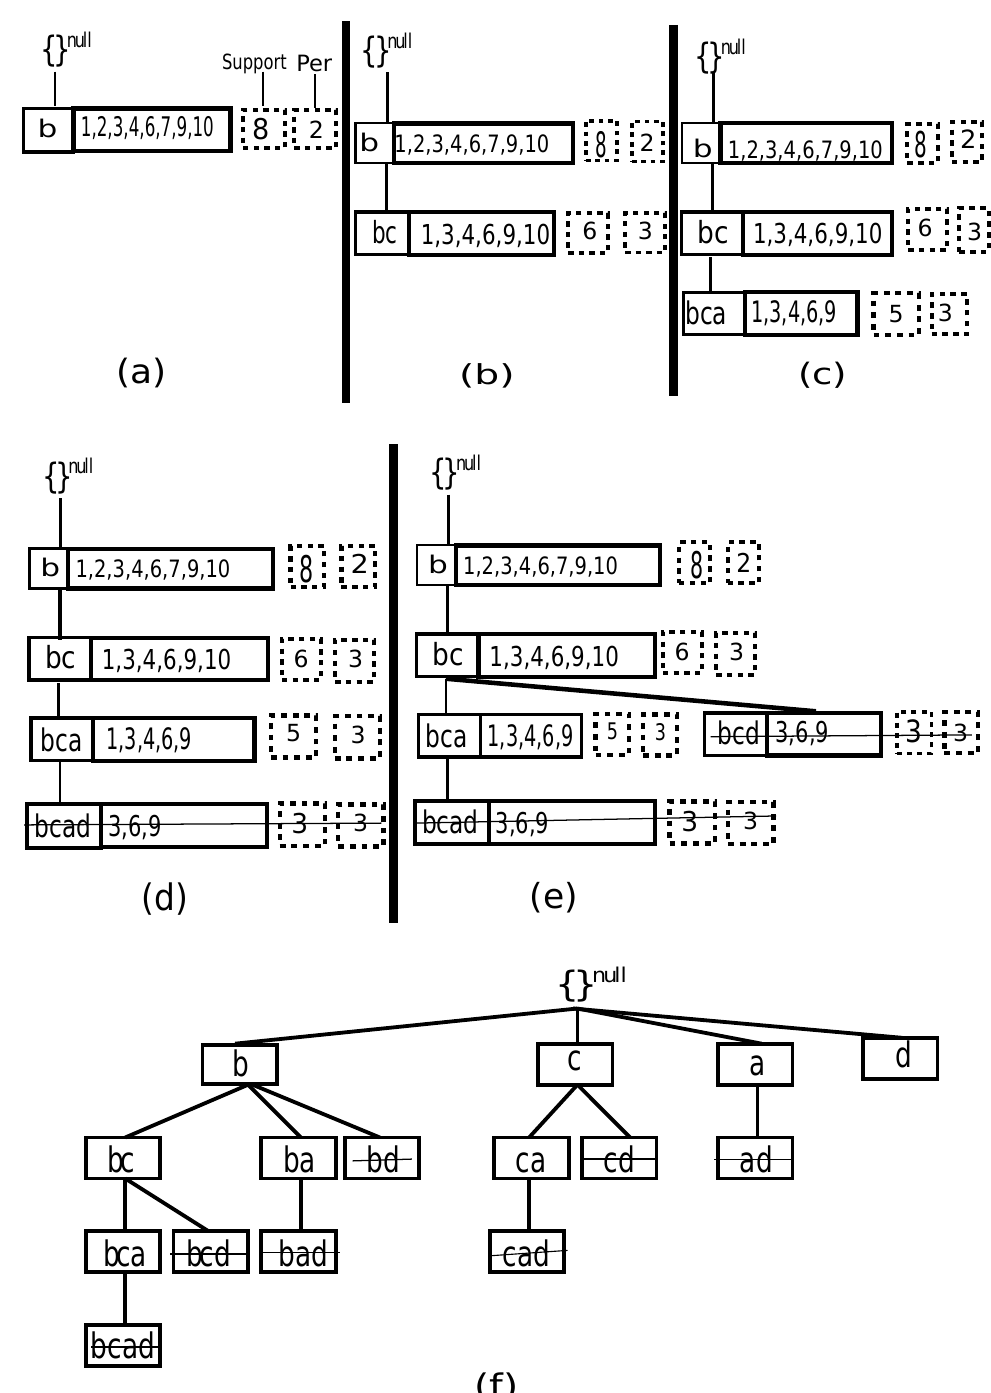
Figure 3. Mining periodic-frequent patterns using DFS: ( a ) identifying ‘ b ’ is periodic-frequent pattern or not, ( b ) identifying ‘ bc ’ is periodic-frequent pattern or not, ( c ) identifying ‘ bca ’ is periodic-frequent pattern or not, ( d ) identifying ‘ bcad ’ is periodic-frequent pattern or not, ( e ) identifying ‘ bcd ’ is periodic- frequent pattern or not, and ( f ) final list of periodic-frequent patterns shown without Strikethrough mark on the